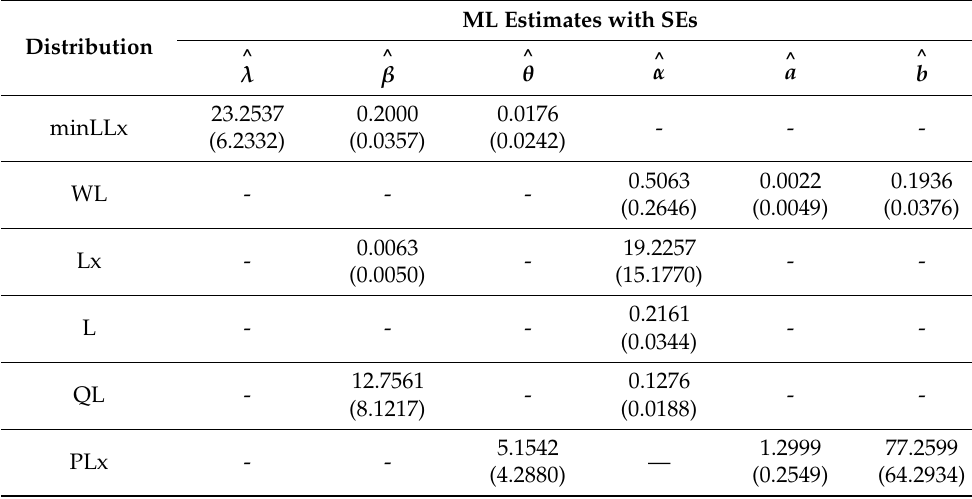
Table 8. The MLEs alongside their accompanying SEs (in parenthesis) for the second data set.